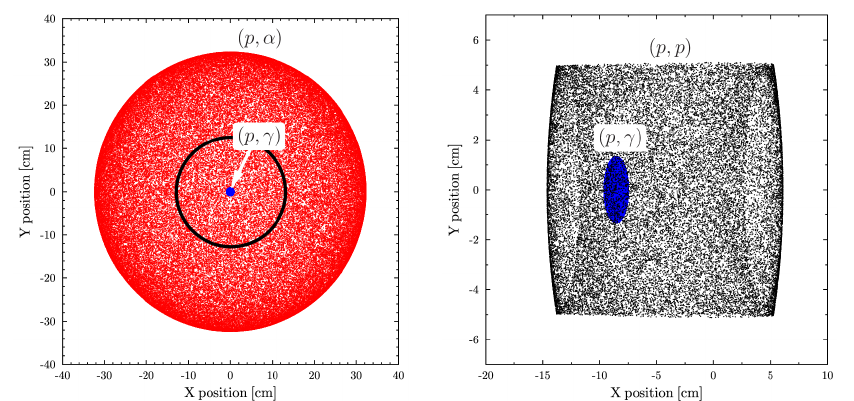
Figure 4. Left: The x-y distribution of heavy residuals following the 59 Cu(p, α ) and 59 Cu(p, γ ) reaction before entering into the first quadrupole in the ESR after the target (drift path is roughly 5 meters). MOCADI has been used to simulate the beam transport [8]. The black circle indicates the typical ESR beam line aperture. Right: The x-y distribution in the dipole (at 53.3 degrees, which is the position used in [3]) of the 59 Cu( p ,γ ) residuals. They can be su ffi ciently measured with a (5 x 5) cm 2 DSSSD detector. In black, also the elastic scattering contribution from 59 Cu(p,p) is shown. The MOCADI simulations include realistic beam apertures; for the reaction, no internal decay patterns of the single residuals are